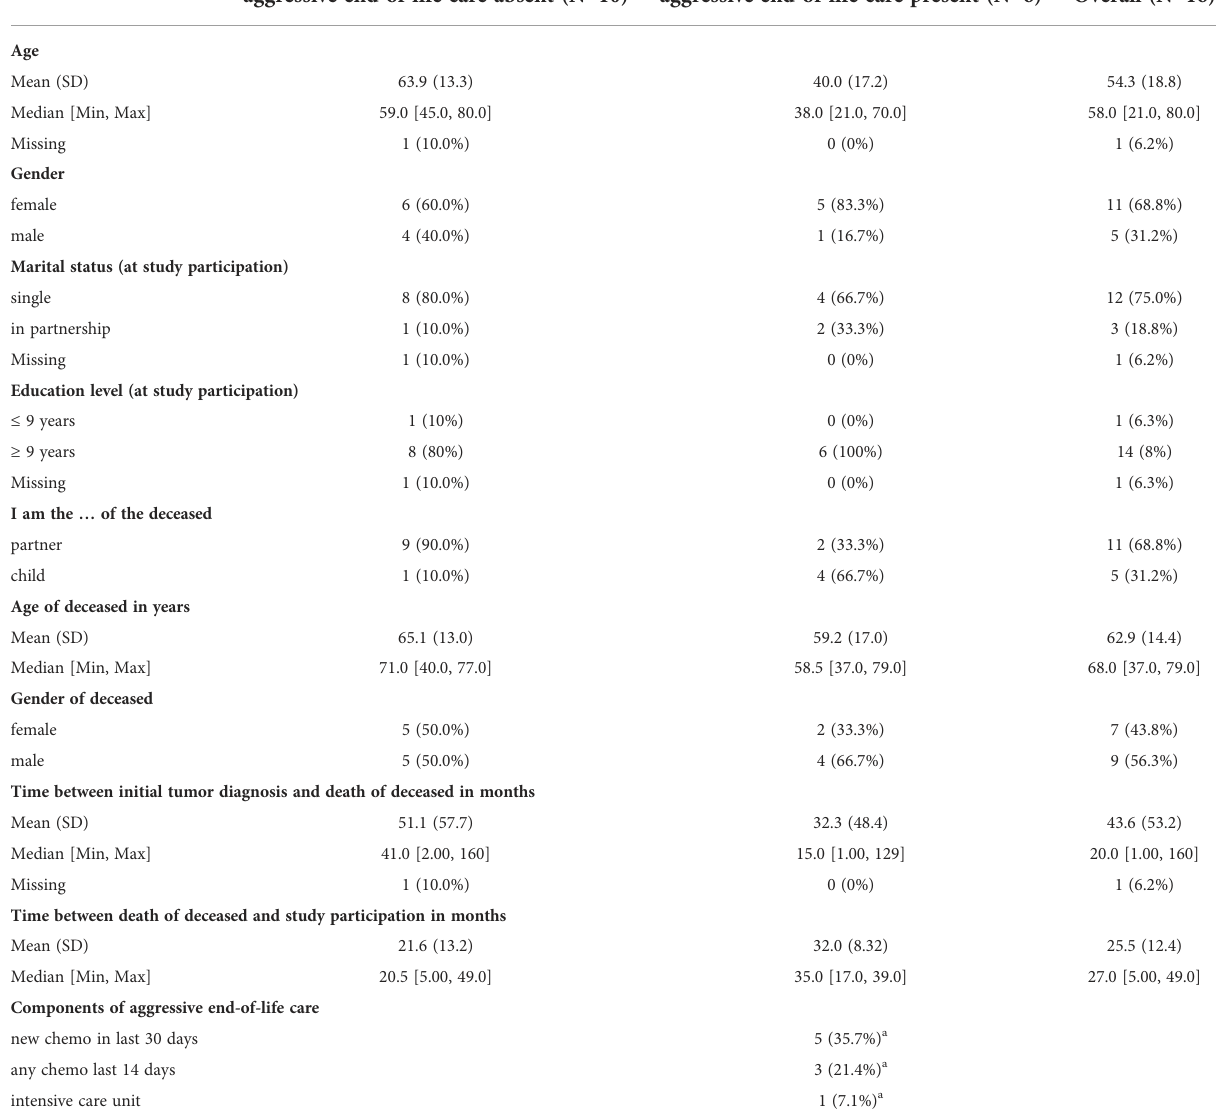
TABLE 1 Characteristics of interviewees strati fi ed by occurrence of aggressive end-of-life care during the patient ’ s treatment course. aggressive end-of-life care absent